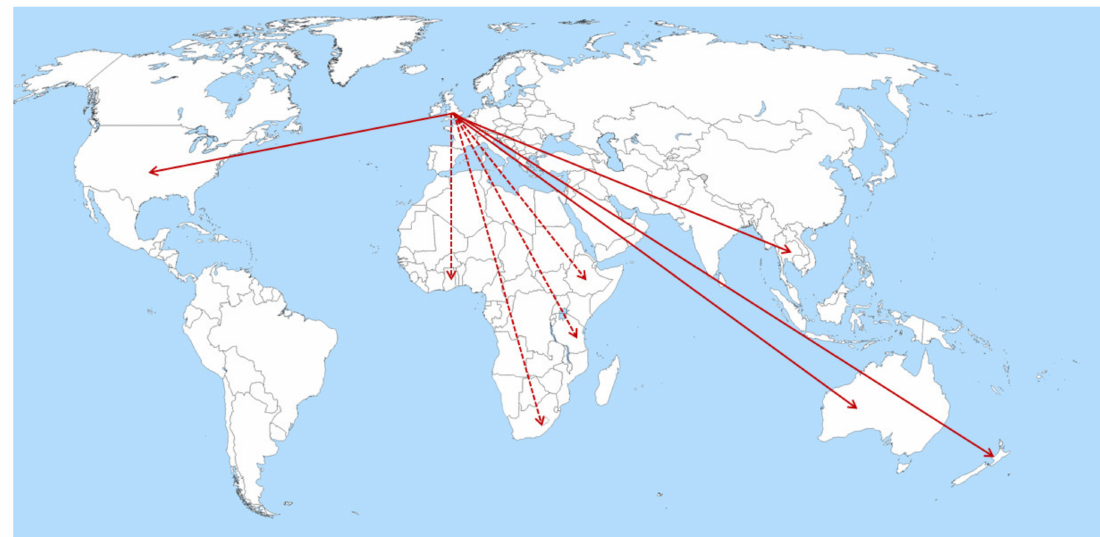
Figure 3. World map displaying the origin of Parkinson’s Disease Nurse Specialists in the UK, with subsequent adoption of a PDNS service globally, including Australia, Thailand [57] and the USA (solid lines). UK-led training programmes have additionally helped to disseminate skills and information to several countries in Africa (dotted